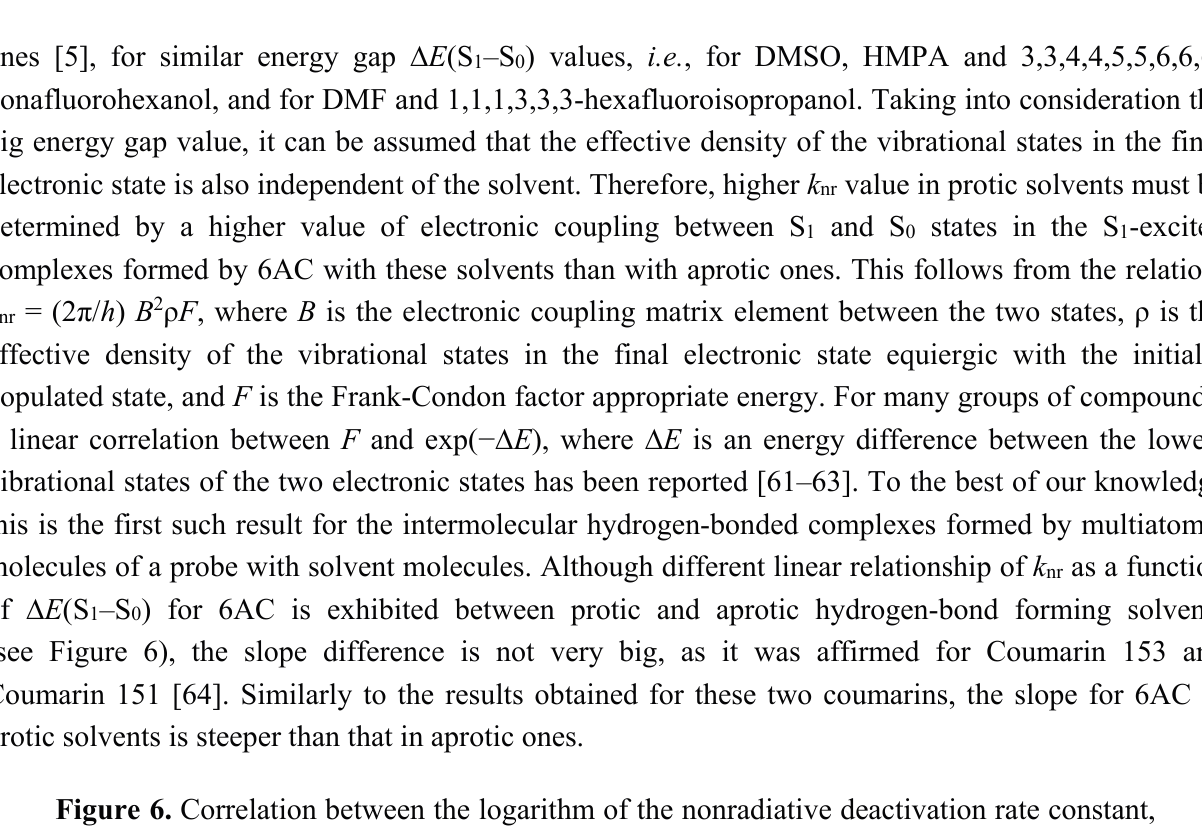
Figure 6. Correlation between the logarithm of the nonradiative deactivation rate constant, log k nr , and the ∆ E (S 1 –S 0 ) = ν (cid:2890)(cid:2923)(cid:2911)(cid:2934) energy gap of 6AC-(solvent) n , n = 1, 2, S 1 -excited complexes in (1) acrylonitrile, (2) propionitrile, (3) DBE, (4) THF, (5) DMF, (6) DMSO, (7) HMPA and of 6AC-(solvent) n , n = 2, 3, S 1 -excited complexes